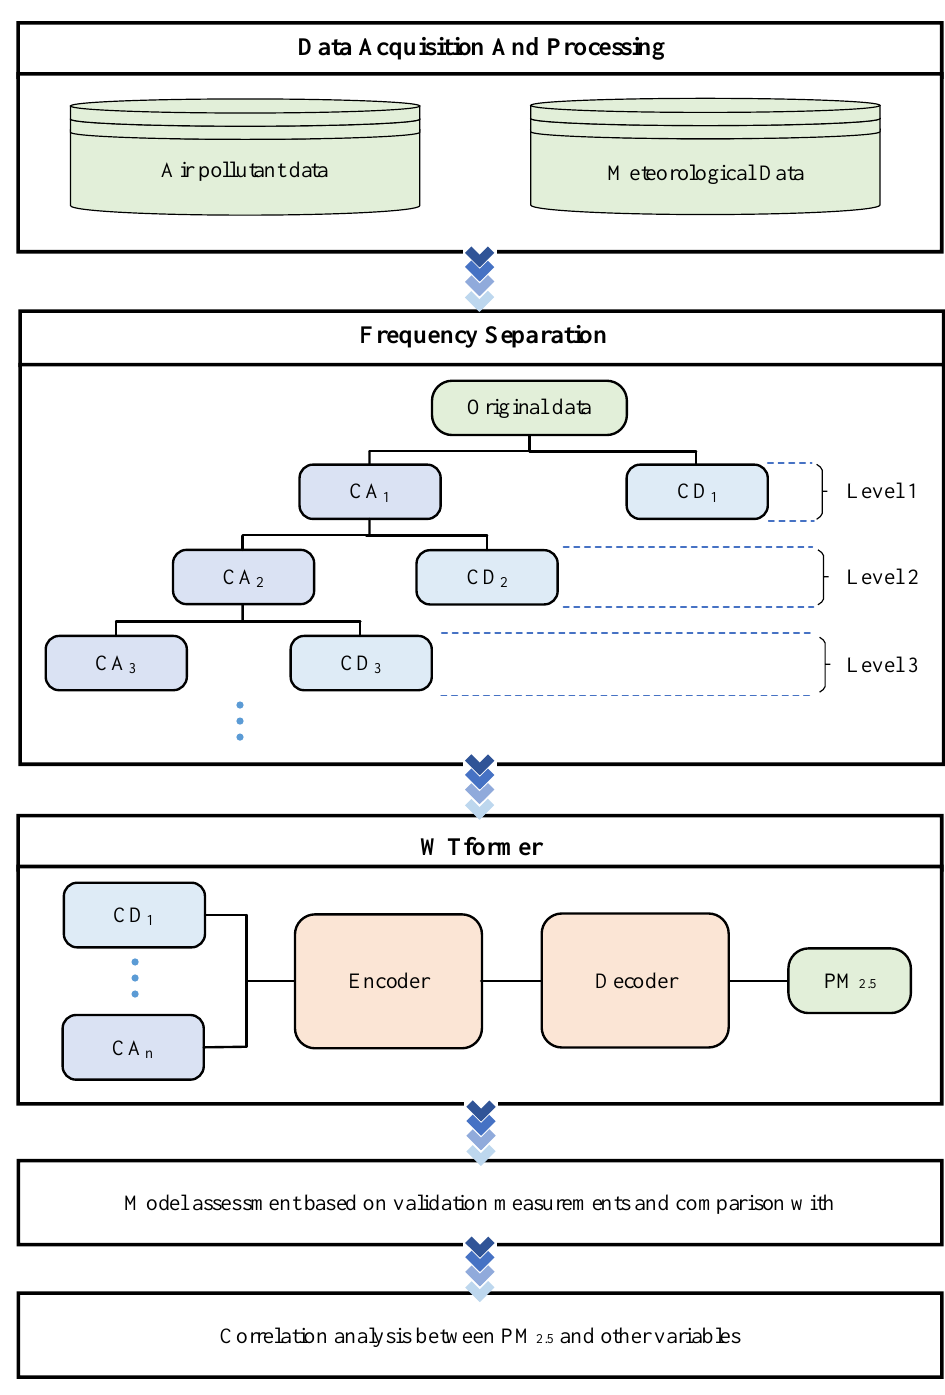
Figure 5. Framework for PM 2.5 data prediction.